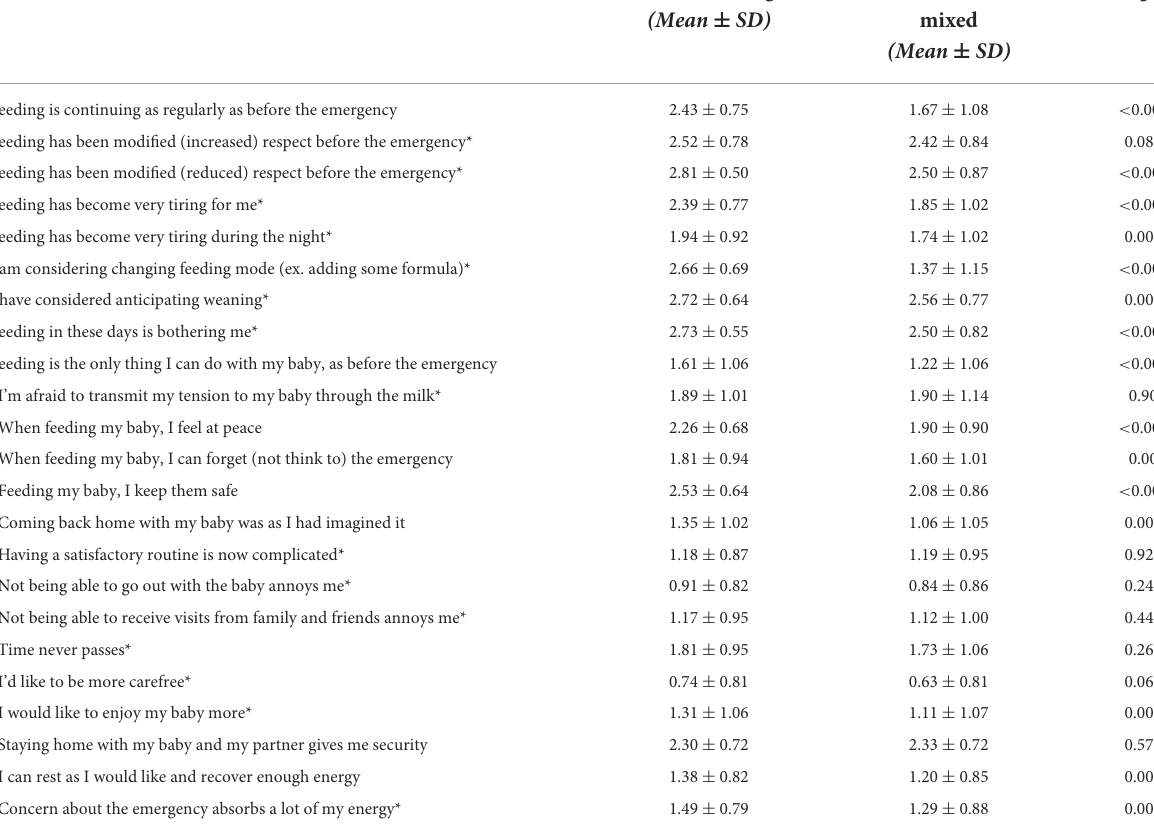
TABLE 3 Mean scores of the Newborn FEeding in emergenCy quesTionnAiRe (NECTAR) items.